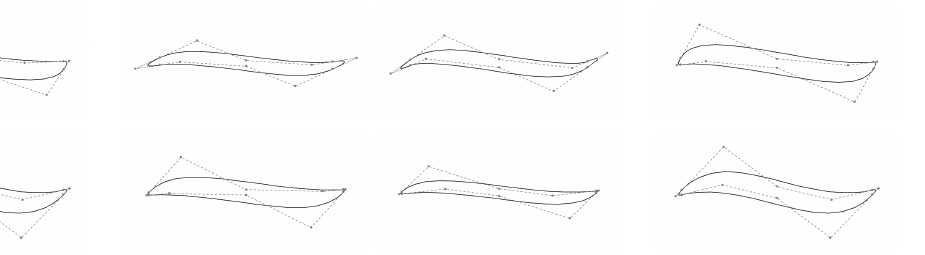
Figure 25. Visualization of the first eight samples.